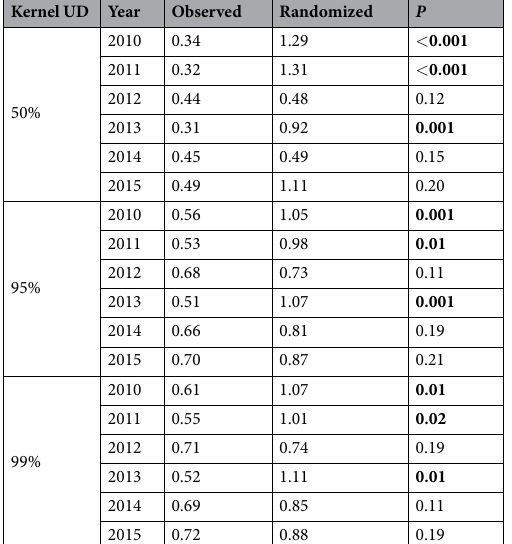
Table 3. Observed and randomized overlap between female and male Cory’s shearwaters Kernel Utilization Distributions (Kernel UD). P represents the proportion of randomized overlaps that were smaller than the observed overlap. Significant differences are shown in